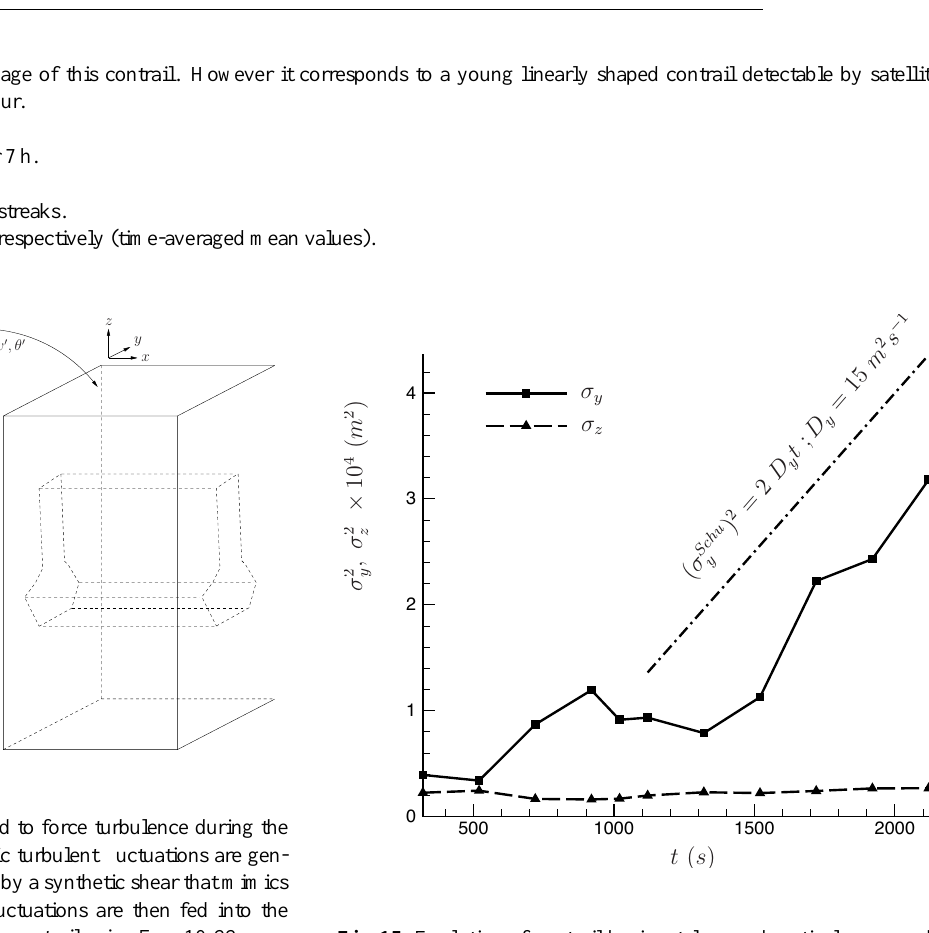
during the late dissipation regime. The dash-dotted line indicates the horizontal spreads of a Gaussian plume (Schumann et al., 1995) with fitted diffusion coefficient, D y ’ 15m 2 s − 1 ( D z ’